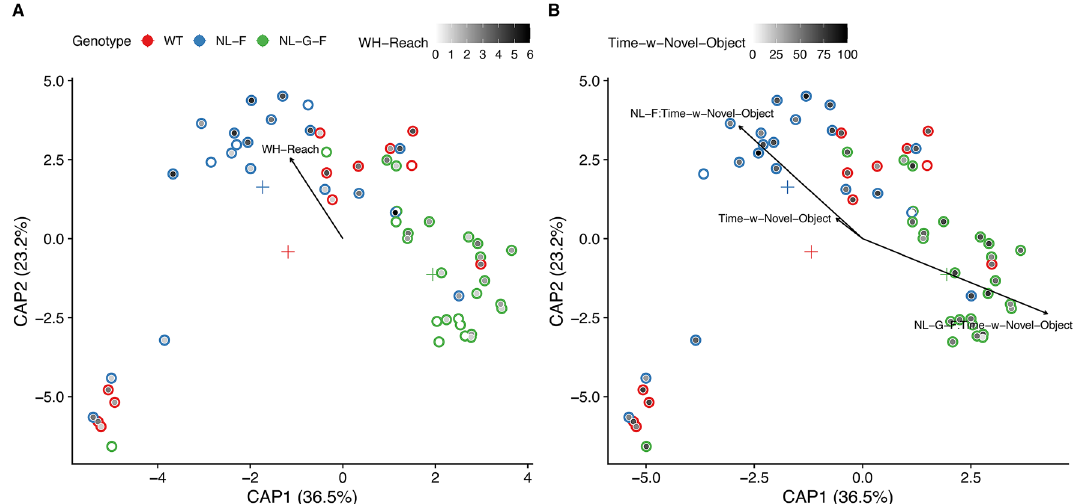
Figure 3. APP genotype ( App NL-G-F , App NL-F , WT) modulates the gut microbiome’s association, as shown in these dbRDA (‘capscale’) ordinations using the Aitchison distance (Euclidean distance on CLR-transformed abundances). Points represent individual fecal samples. Plus signs mark the centroid for each genotype (colored the same as the point edges). The inside of the points are colored according to percent time freezing during the tone in the wire hang reach score (WH-Reach) or time spent exploring the novel object (Time-w-Novel-Object). PERMANOVA tests support these associations ( p < 0.05 for both). App NL-G-F mice: n = 13 females and 14 males; App NL-F mice: n = 11 females and 14 males; WT mice: n = 11 females and 11